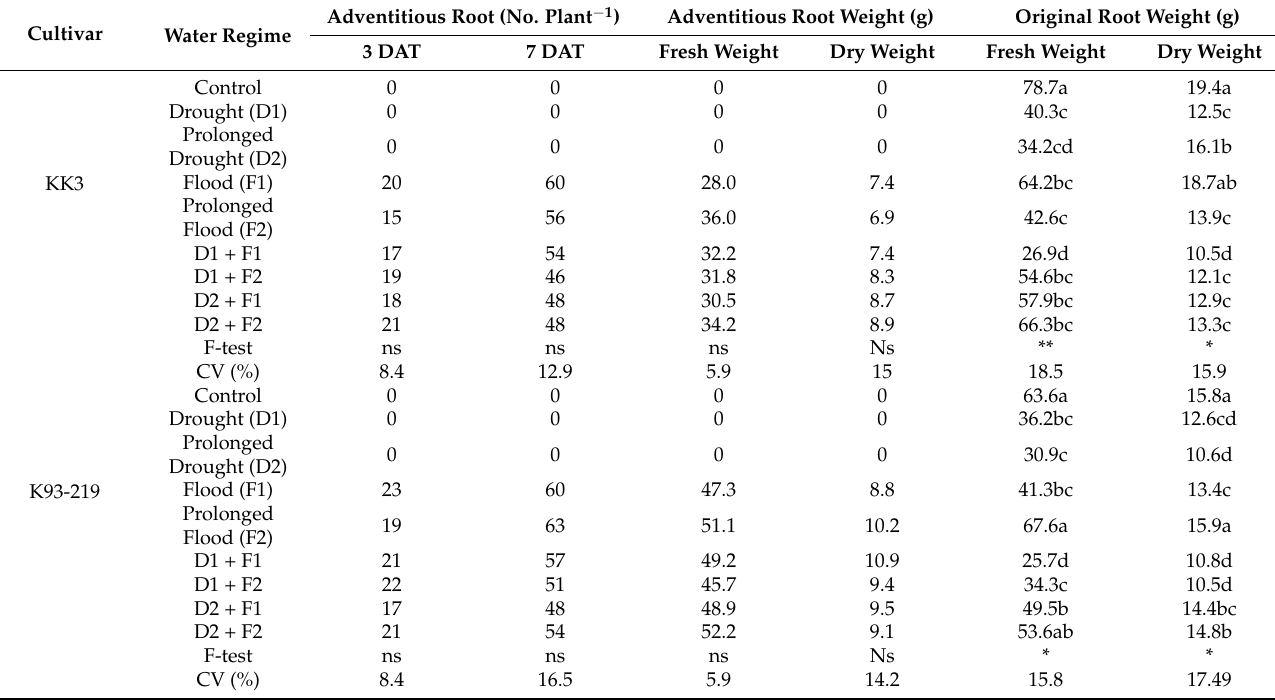
Table 4. Adventitious root number and adventitious fresh and dry root weight of sugarcane at 3 and 7 days after treated (DAT), and fresh and dry original root weight at harvest as affected by drought, flood, and combined treatments. Experiment 1.